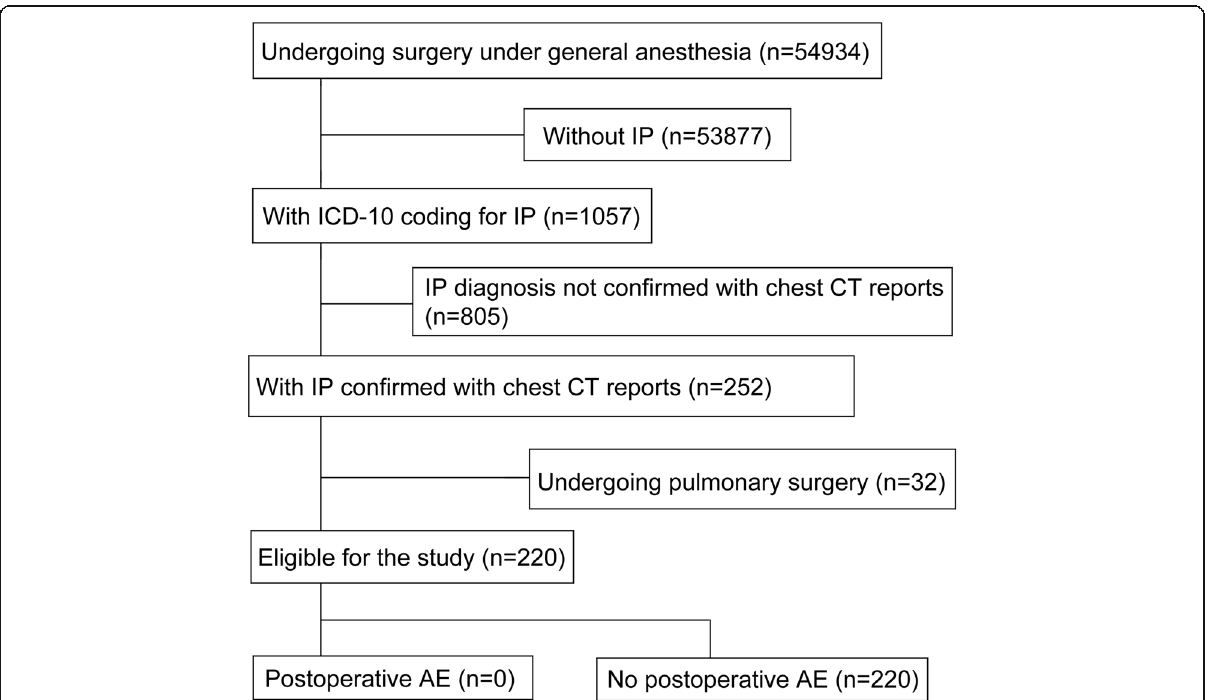
Fig. 1 Flow diagram of the study participants. IP interstitial pneumonia, ICD International Classification of Disease, CT computed tomography, AE acute exacerbation